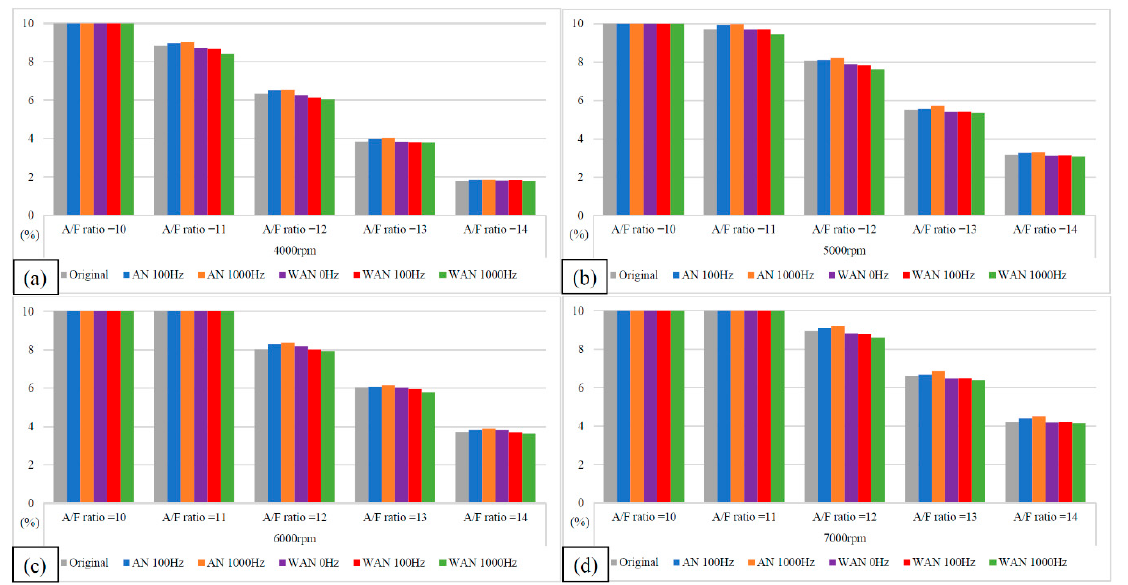
Figure 11. The CO values of WAN and AN with different frequencies at ( a ) 4000 rpm, ( b ) 5000 rpm, ( c ) 6000 rpm, and ( d ) 7000 rpm.